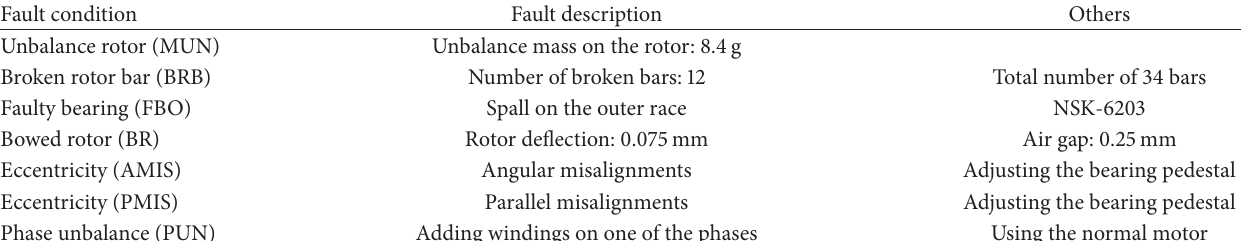
Table 3: A description of the faulty induction motors.